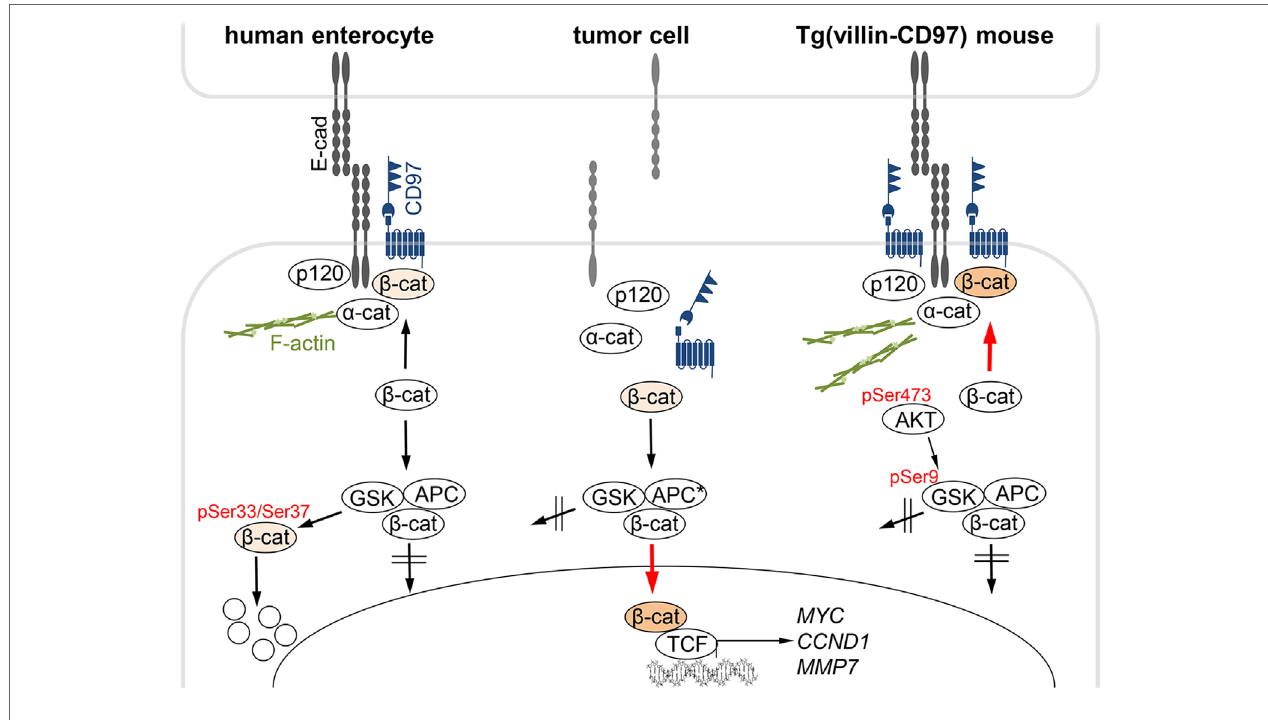
FigUre 7 | CD97: β -catenin interaction in normal and malignant intestinal epithelial cells. Left: in normal human enterocytes, CD97 is part of E-cadherin (Ecad)-based adherens junctions. CD97 physically interacts with Ecad, β -catenin, and likely, only in mice, p120-catenin, but not with a-catenin that links adherens junctions to the F-actin cortex. Cytoplasmic β -catenin is phosphorylated at Ser33/Ser37, which initiates its ubiquitination and degradation in the proteasome. Middle: In colorectal tumor cells, Ecad disappeared, and adherens junctions were dissolved. CD97 localized in the cytoplasm. In parallel, β -catenin appeared in the cytoplasm and in the nucleus, where it binds to TCF transcription factors, thus driving colorectal carcinogenesis by activating genes, such as CCND1 , MYC , or MMP7 . CD97 did not regulate nuclear β -catenin-dependent transcriptional activity. Right: In Tg(villin-CD97) mice, CD97 regulates the localization and stability of β -catenin in enterocytes (20). CD97 expression correlated with the amount of non-phosphorylated, stable β -catenin. AKT/GSK-3 β signaling is involved in the stabilization of β -catenin through CD97. Activated AKT (pSer473) phosphorylates GSK-3 β at Ser9, thereby inhibiting the ability of GSK-3 β to phosphorylate β -catenin (27). In Tg(villin-CD97) mice the cytoplasmic sites of the contacts were especially condensed and actin microfilaments were pronounced. Examined phosphorylation sites (20) are indicated in